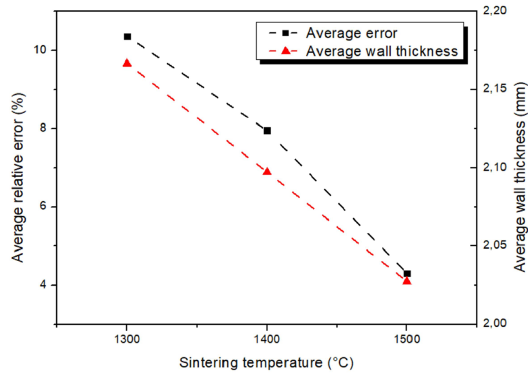
Figure 6. Average relative error, by comparing values in Table 1 and Table 2, and average tube wall thickness plotted against the sintering temperature. Table 2. Maximum tensile stresses (MPa) found on the spatial stress distribution during O-ring compression tests. Solid loading (vol%)